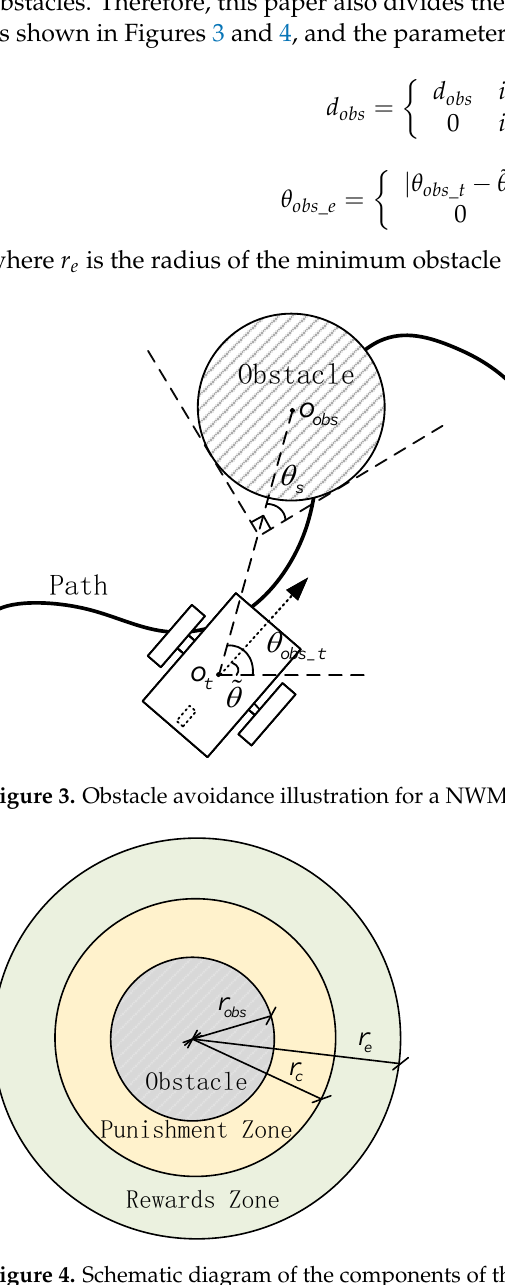
Figure 4. Schematic diagram of the components of the obstacle avoidance